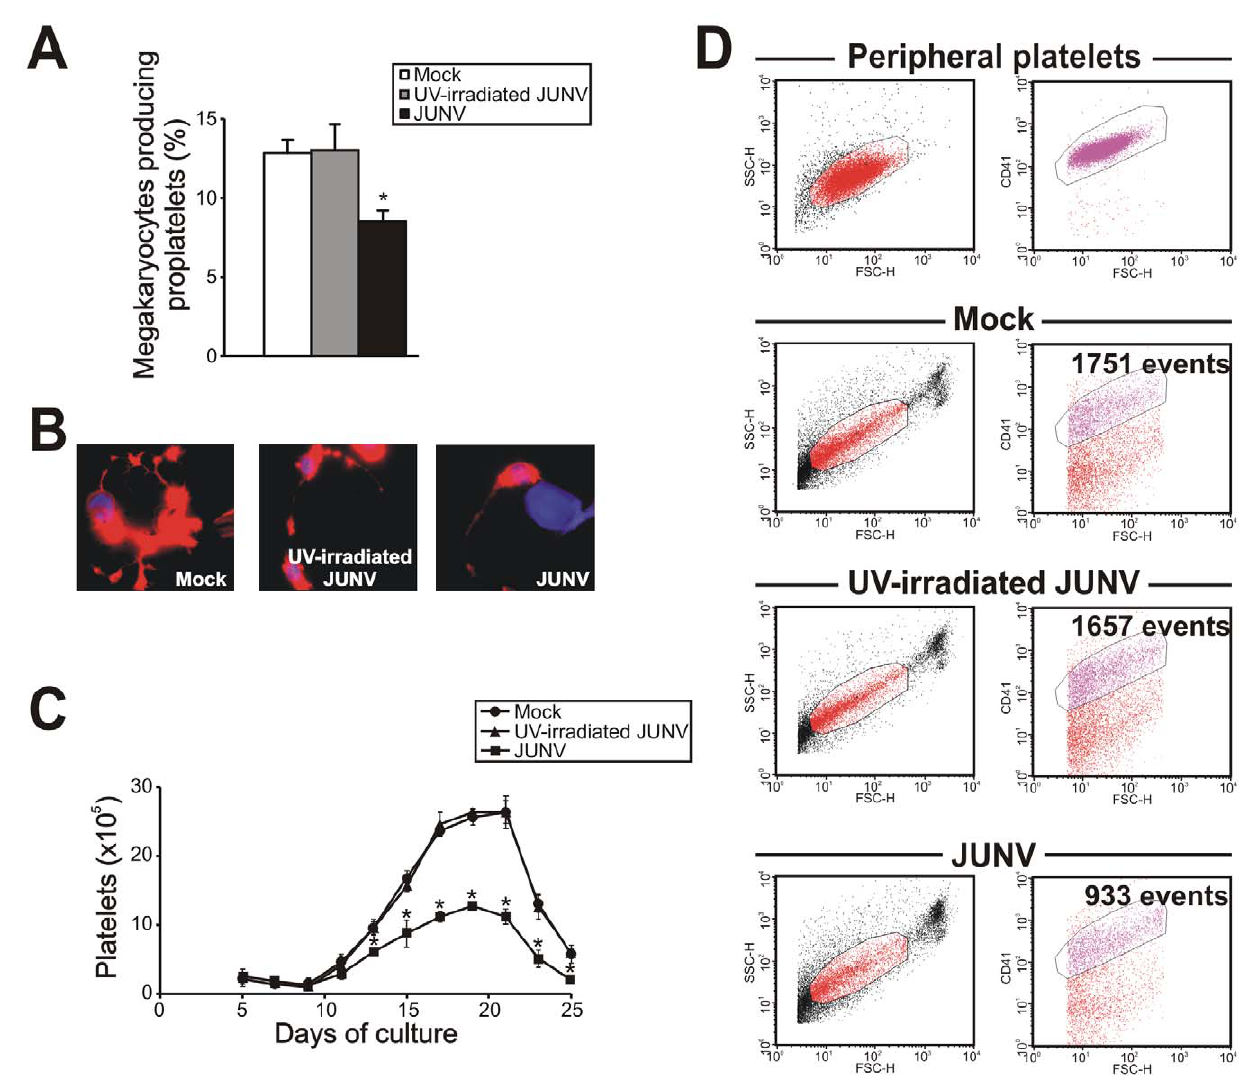
Figure 3. JUNV infection impairs proplatelet production and platelet release. CD34 + cells were mock-infected or infected with UV- irradiated JUNV or JUNV and then stimulated with TPO. (A) The number of megakaryocytes displaying proplatelets was determined at day 12 of the culture by F-actin and nuclear staining with phalloidin-TRITC and DAPI, respectively, and examined by fluorescence microscopy. The values represent the mean 6 SEM of four independent experiments. (B) A representative picture of a proplatelet-displaying megakaryocyte. (C) Plt count was determined by flow cytometry. At different days, culture aliquots were stained with an anti-CD41-FITC mAb and the acquisition rate was fixed at 1 m l/ sec for 100 sec. Events were collected without gating using a log scale for size (FSC) and intracellular granularity (SSC). An analytical gate was determined based on the scatter properties of peripheral blood platelets treated similarly. Culture-derived platelets were counted as CD41 + events with the same scatter properties as blood platelets. The values are expressed as platelets ( 6 10 5 ) and represent the mean 6 SEM of six independent experiments. * indicates p , 0.05 vs. UV-irradiated JUNV or mock. (D) A representative flow cytometric analysis 15 days after TPO stimulation.